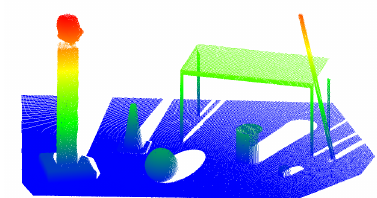
Figure 6: The original point cloud obtained with a Leica C10 TLS